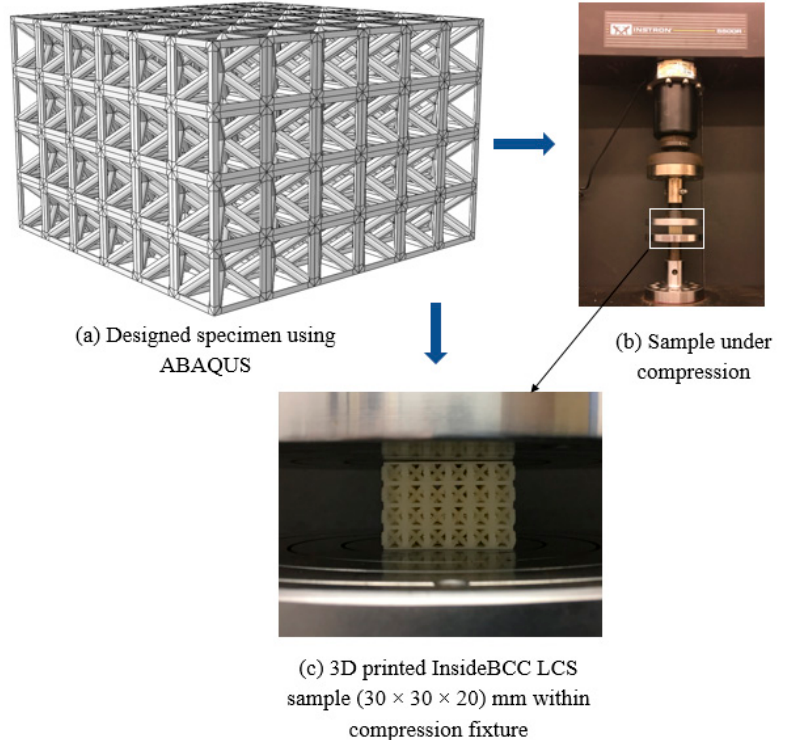
Figure 4. Experimental procedures, ( a ) specimen design in MTD; ( b ) fabricated sample under compression; and ( c ) zoomed ‐ in view of 3D printed sample within compression test fixture.